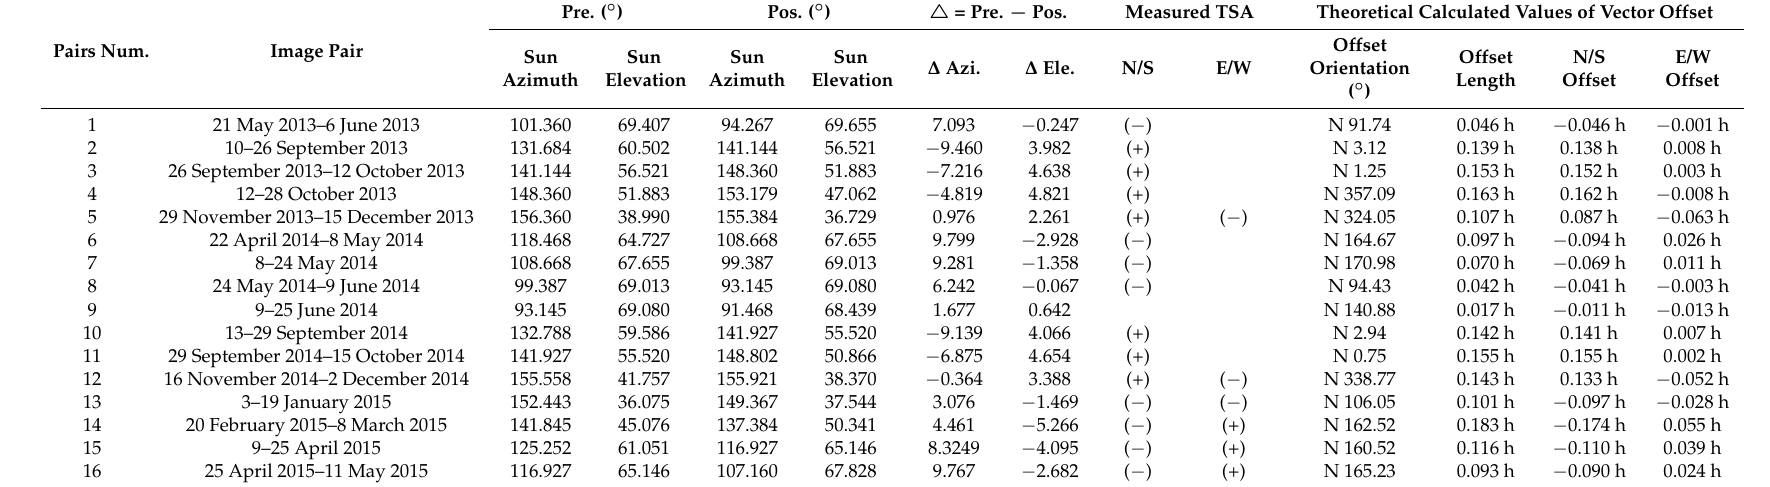
Table A2. Relationship between the TSA and Sun angles of Landsat 8 correlation images pairs.